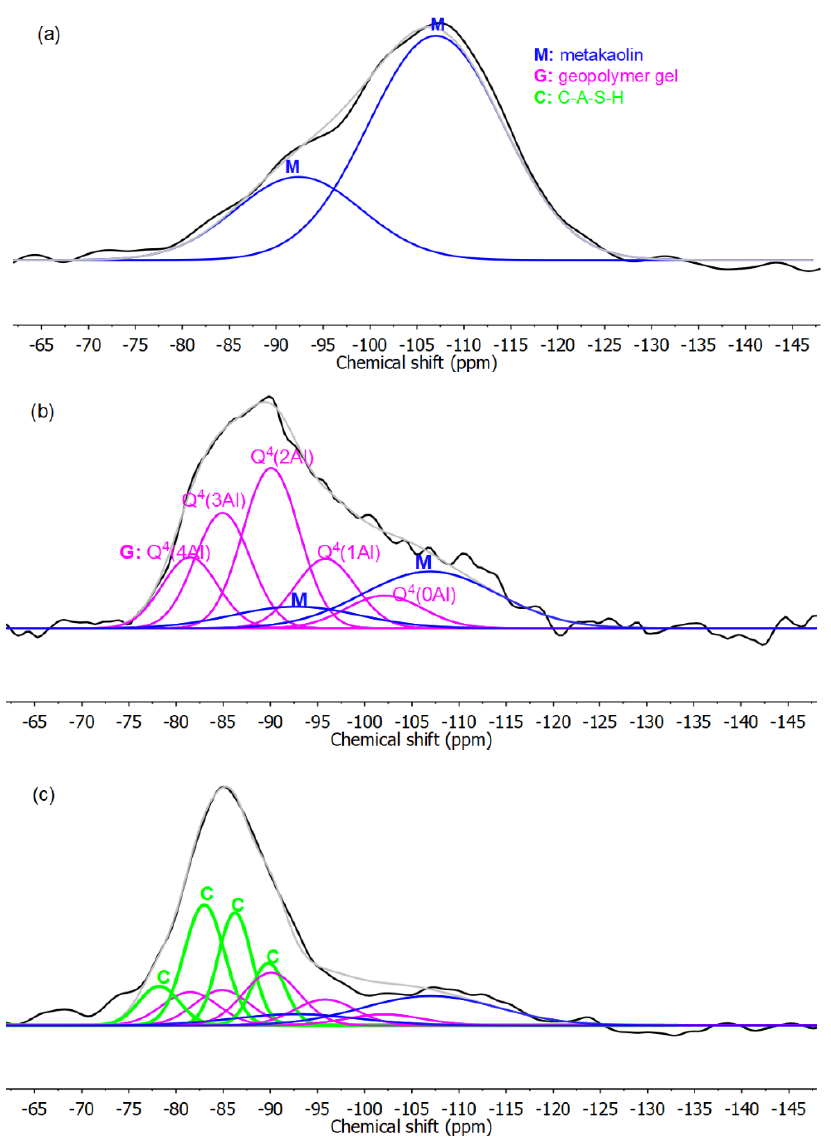
Figure 5. Deconvolution of the 29 Si NMR spectra of ( a ) HCl residue, ( b ) SAM residue, and ( c ) specimen before chemical extractions for the Ca-mixture with Ca/Si of 0.15 and Si/Al of 1.5. The sum of deconvoluted peaks (silver) is close to the experimental spectrum (black).